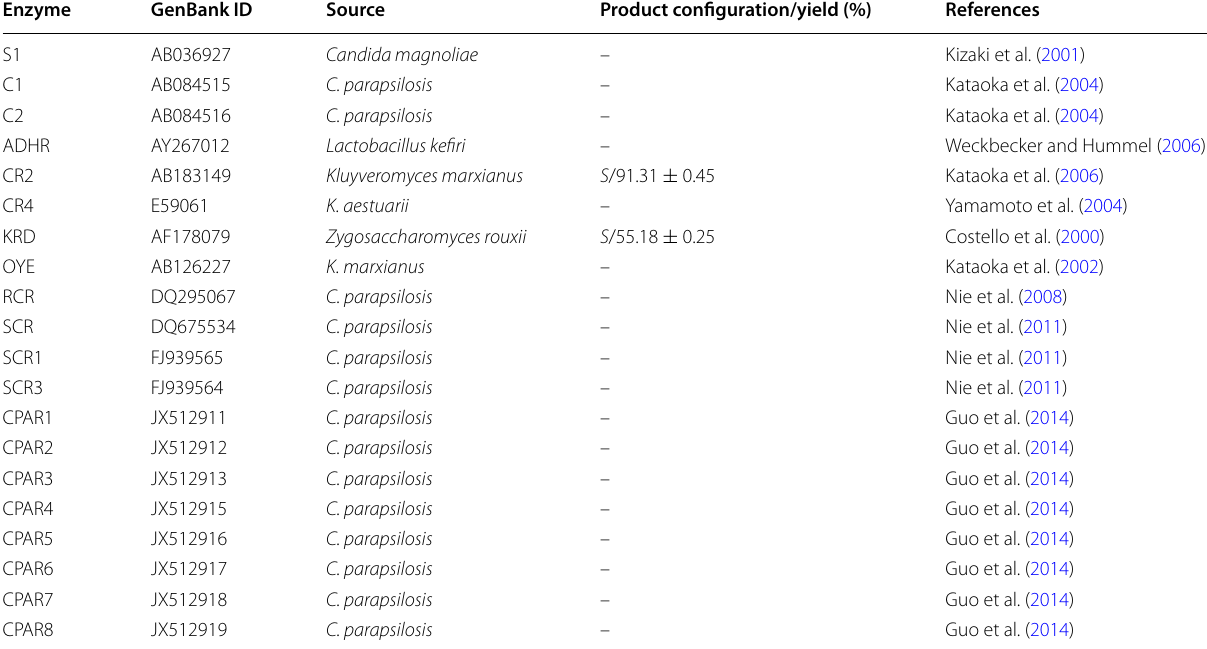
All reactions were carried out in 2 mL Tris–HCl buffer (0.05 mol L − 1 , pH 8.0) comprising 1 g L − 1 DKTP with addition of 10 g L − 1 glucose and 0.02 mmol L − 1 NADP + at 30 °C and 200 rpm for 12 h. All the results were the average of three parallel replicates